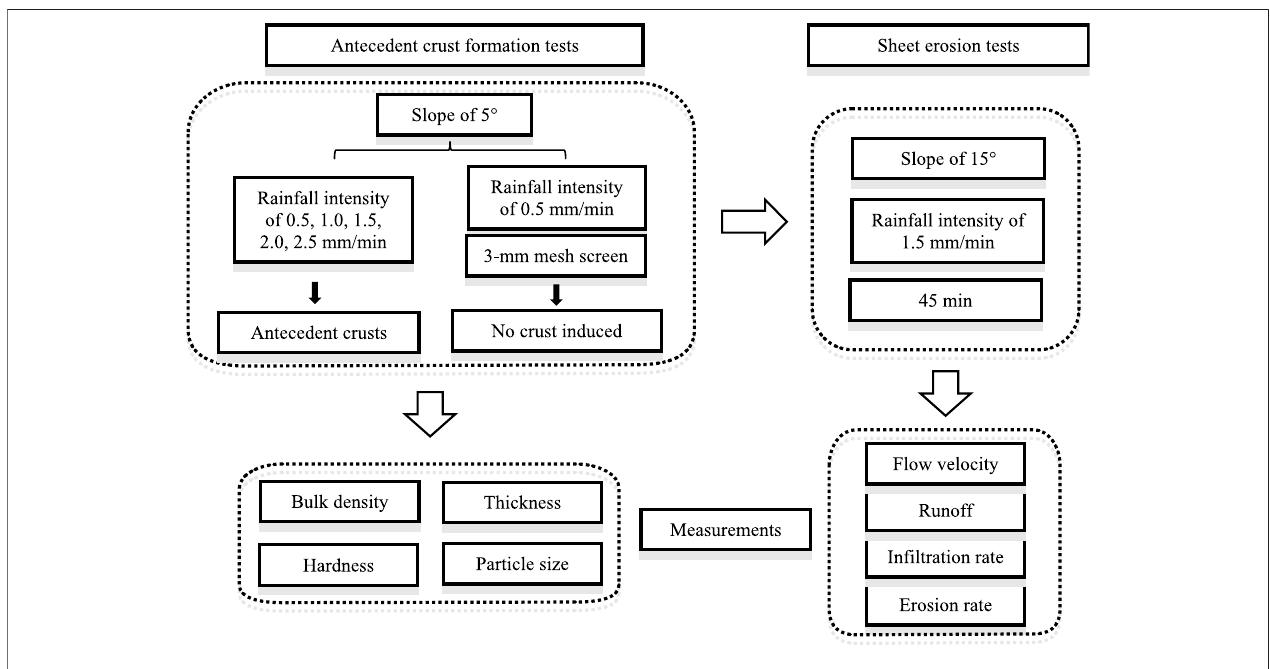
FIGURE 1 | Experiment